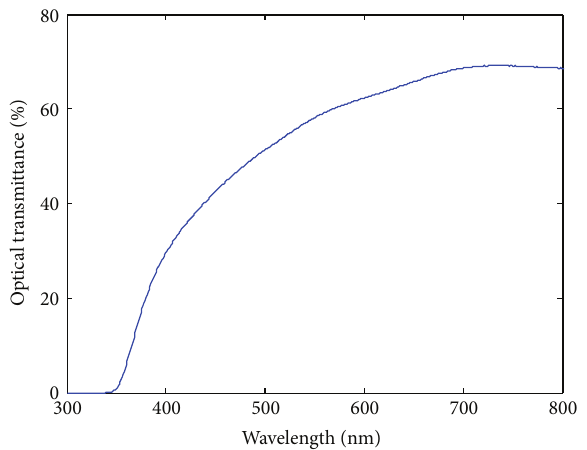
Figure 5: Optical transmittance spectrum of ZnO:Zr:F thin films.